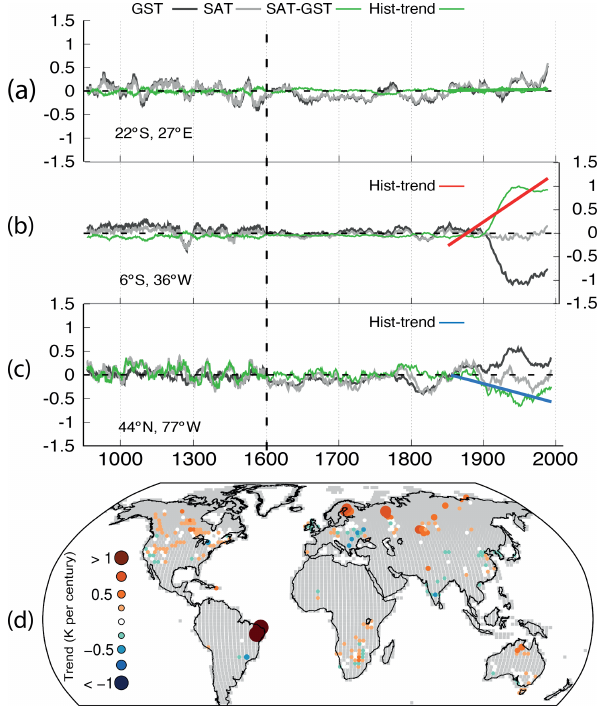
Figure 5. LM evolution of SAT and GST anomalies, SAT minus GST, and the linear trends of SAT minus GST over the 1850– 2005CE period for three different grid points with borehole records in ALL- F 2 as an example. Each grid point illustrates a possible case of the long-term SAT–GST relationship: (a) strong coupling during the LM, (b) decreasing GST relative to SAT and (c) increasing GST relative to SAT during industrial times. (d) Spatial distribution of linear trends in SAT minus GST anomalies over the 1850–2005CE period evaluated at every grid point with the presence of a borehole site using the ALL- F ensemble mean. Grid points showing statisti- cally significant trends ( p < 0 . 05) are colored in red/blue depending on whether they are increasing/decreasing SAT–GST